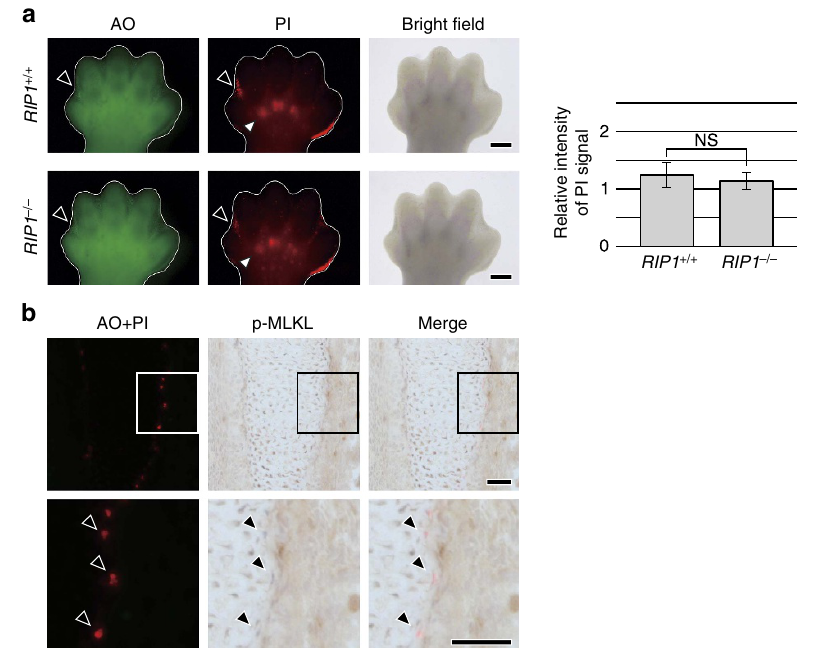
Figure 5 | No relation of necroptosis to PI foci at the bone surface. ( a ) PI foci in the phalanges of an RIP1 KO embryo. At E14.5, an RIP1 KO ( RIP1 (cid:2) / (cid:2) ) embryo and a control ( RIP1 þ / þ ) embryo were injected with AO and PI, and the right hind limb buds were observed by fluorescence stereomicroscopy. Scale bar, 400 m m. Bar graphs show quantitative assessment of PI signals in the phalanges. The relative intensity of PI signals in the phalangeal area was calculated as the PI signals in the area divided by the PI signals in the palmar region. Data are represented as the mean ± s.d.; n ¼ 3 for RIP1 þ / þ embryos and n ¼ 3 for RIP1 (cid:2) / (cid:2) embryos. NS: P ¼ 0.158 for comparison between RIP1 (cid:2) / (cid:2) and RIP1 þ / þ embryos. Because these embryos were at a slightly earlier stage of development, PI signals were lower in the phalangeal region compared with the other embryos. ( b ) PI-positive cells did not show phosphorylation of MLKL. A vertical cryosection of the forelimb of an E14.5 embryo injected with AO and PI was subjected to immunostaining by an anti-phospho MLKL antibody. Scale bar, 50 m